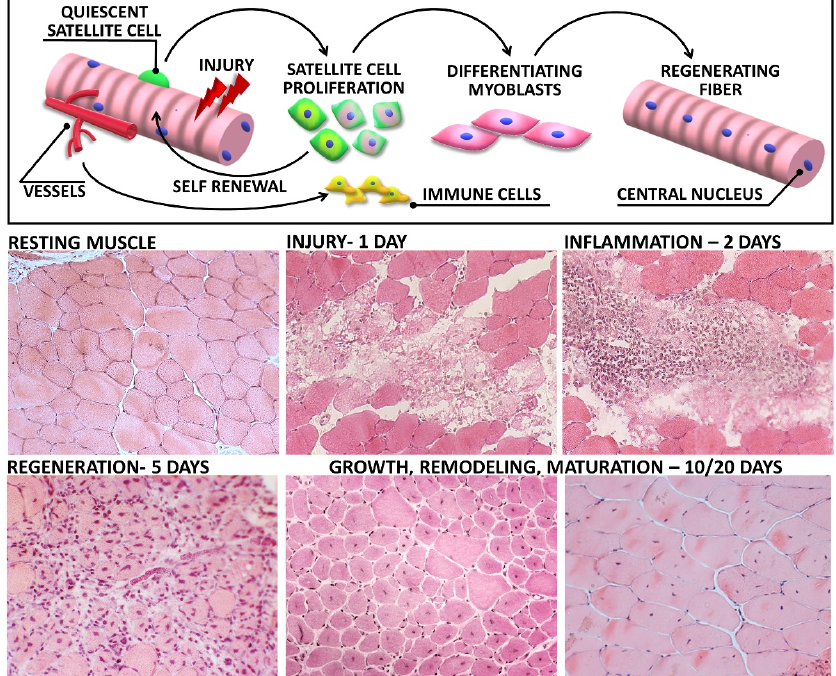
Figure 2. Skeletal muscle regeneration upon acute injury: The upper panel shows a schematic representation of relevant biological responses activated in muscle tissue following damage. Lower panel reports haematoxylin and eosin images of muscle sections, representative of each step of muscle degeneration and regeneration after cardiotoxin (CTX) injection. Early, after the injection (1 day), necrotic myofibers are evident in damaged muscle. During the second day after damage, the lesion is dominated by inflammatory infiltrated cells. Activated satellite cells undergo active proliferation, and newly regenerating fibers appears within the first week. Ten days after injection, the overall tissue architecture is restored and most of myofibers display centrally located nuclei. Regenerated myofibers then undergo progressive growth and maturation, highlighted by the increasing cross ‐ sectional area and the nuclear relocation towards the periphery.